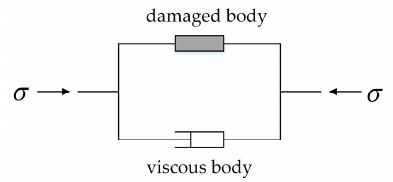
Figure 9. Visco-elastic damage constitutive model.